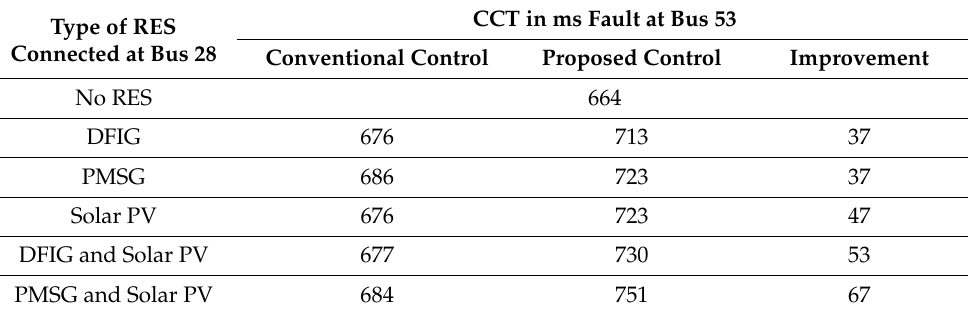
Table 4. CCT when connected to different RES at various fault instants.